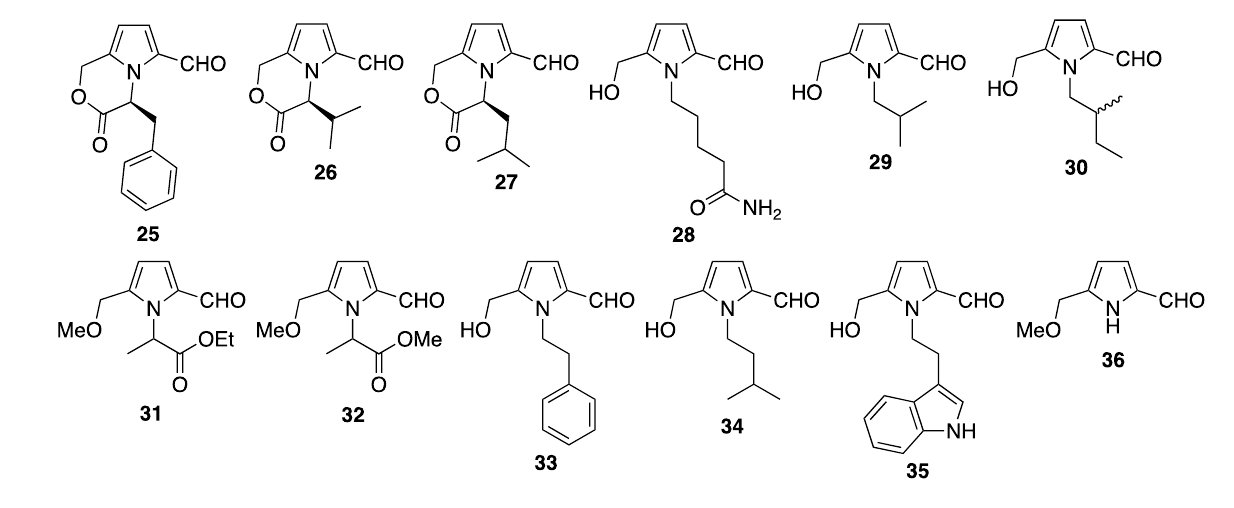
Figure 2. Structures of Py-2-Cs from fungi.